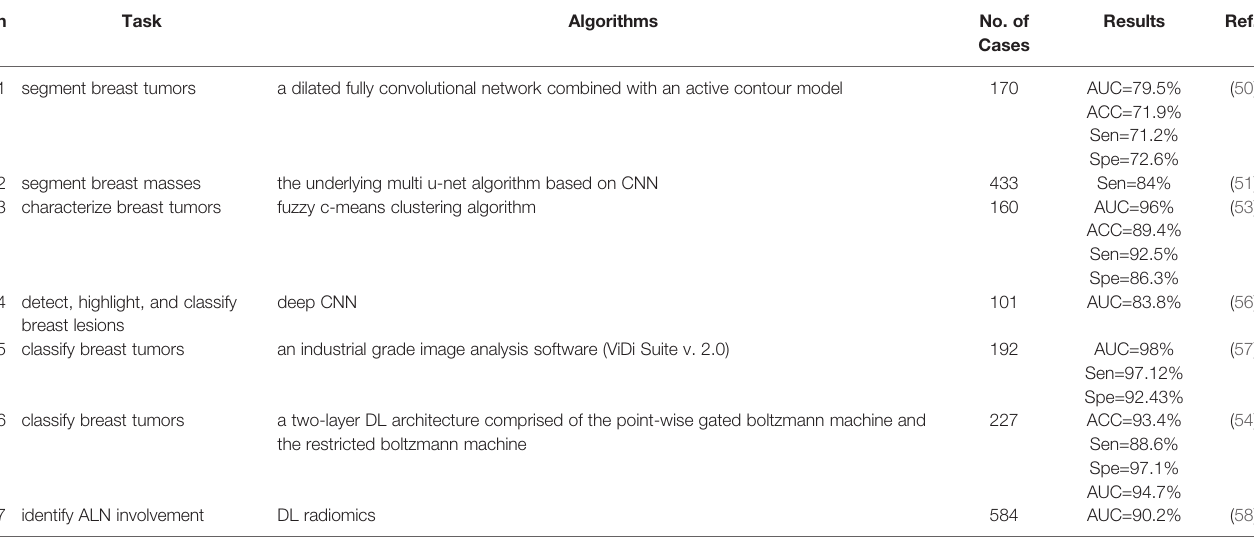
TABLE 2 | Summary of key studies on the role of AI in breast